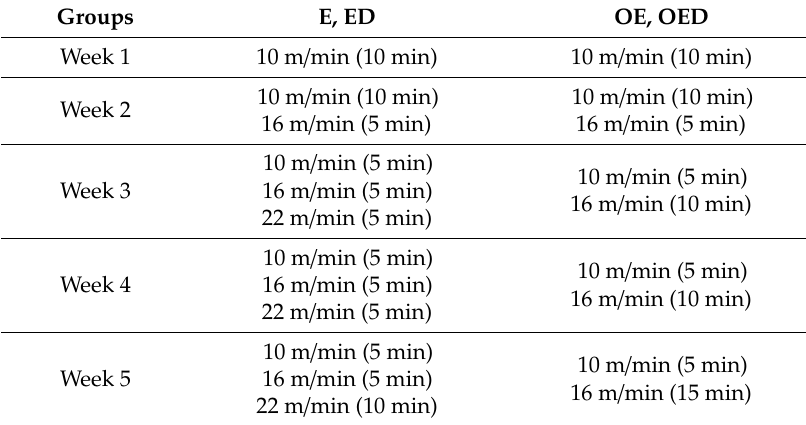
Table 2. Exercise protocol. Exercise protocol per week for groups: E; exercise, ED; diazoxide exercise, OE; obese exercise, OED; obese diazoxide exercise. The speed is displayed in meters per minute and the time for which this speed was applied is shown in